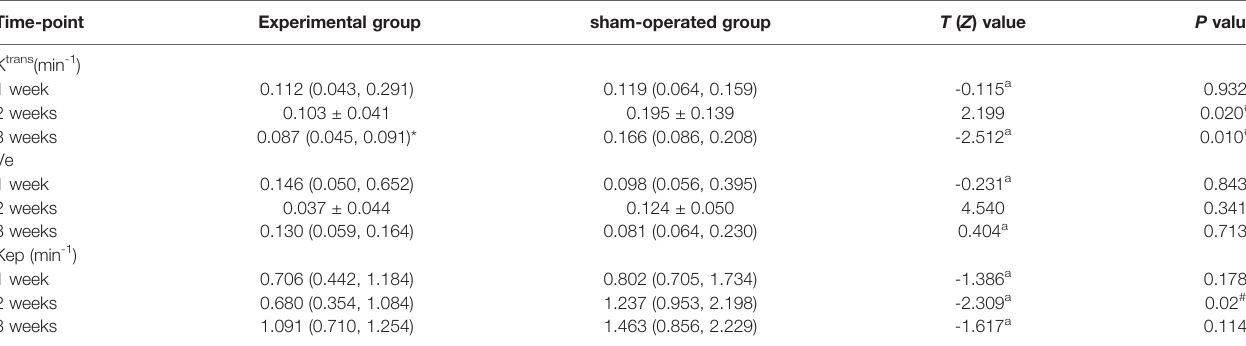
TABLE 1 | Comparison of K trans , Ve, and Kep at each time-point between the experimental group and the sham-operated group. Time-point